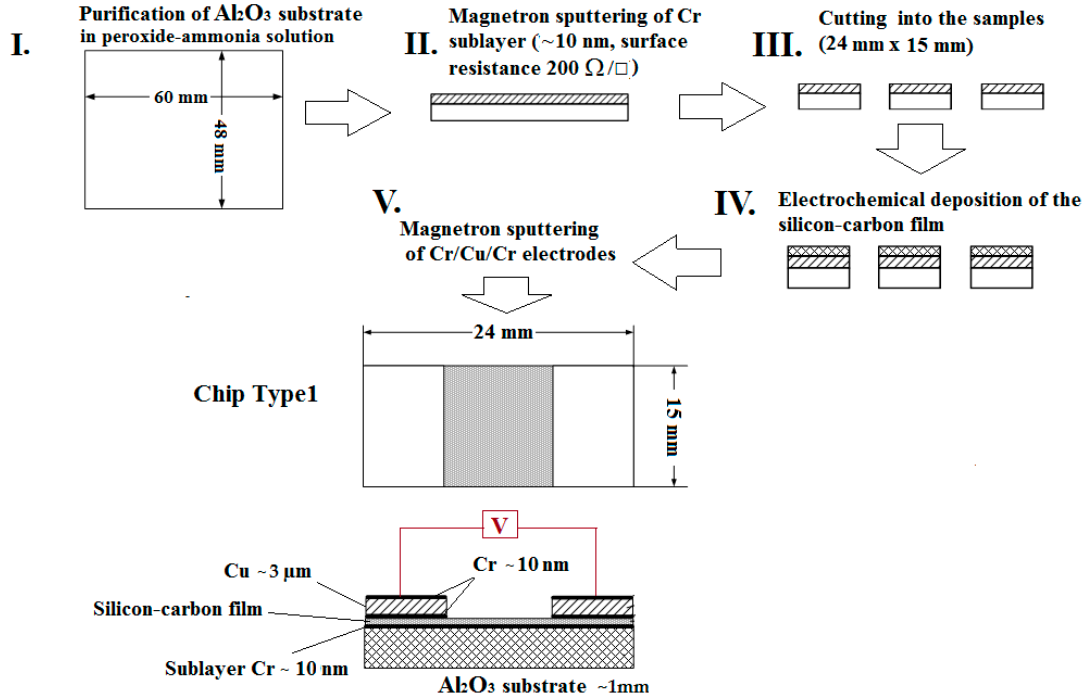
Figure 1. General sensor fabrication process on an Al 2 O 3 substrate with a chromium sublayer (type-1).